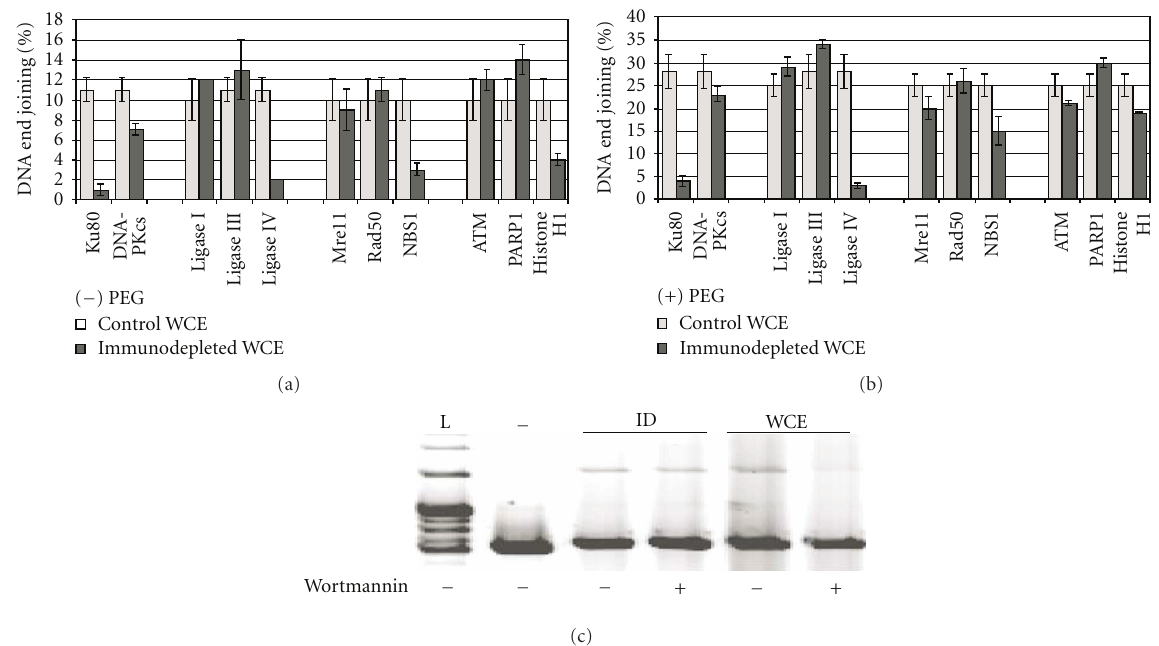
Figure 3: DNA end joining with immunodepleted extracts. HeLa WCE was immunodepleted for the various potential NHEJ proteins indicated, and immunodepletion ( ≥ 3-fold) of the target protein was confirmed by western blot (data not shown). The individual immunodepleted extracts were then assayed for DNA end-joining activity at 30 ◦ C for 2 hrs. (a) Results of DNA end-joining reactions performed in the absence of 5% PEG. (b) Results of DNA end-joining reactions performed in the presence of 5% PEG. All reactions were performed in triplicate and error bars indicate the standard deviation. (c) Wortmannin-insensitive DNA end joining is detectable in the DNA-PK cs immunodepleted HeLa WCE in the absence of PEG. Reactions were run in the absence of 5% PEG and where indicated, in the presence of 10 μ M wortmannin at 30 ◦ C for 2 hrs. (L) T4 DNA ligase positive control; ( − ) negative control; (ID) DNA-PK cs -immunodepleted